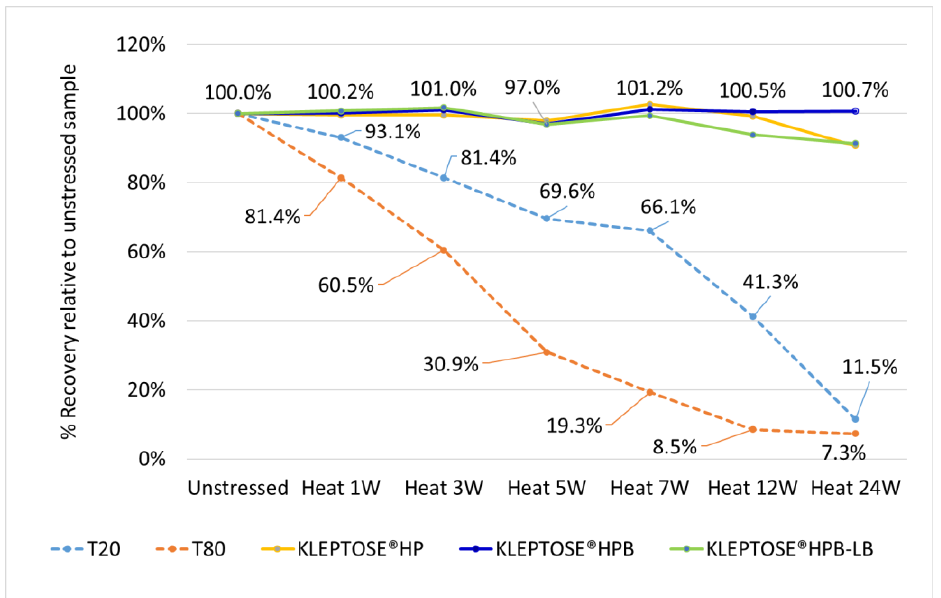
Figure 2. Thermal stability study of polysorbates and KLEPTOSE® HPβCD at 40 °C/75% RH within 24 weeks (W).